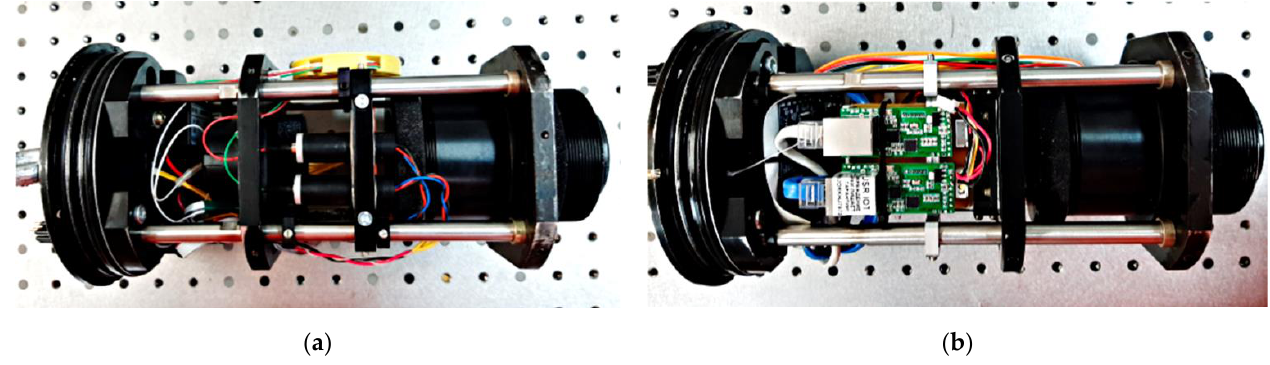
Figure 3. DHC lighting ( a ) and recording ( b ) modules outside sealed cases.